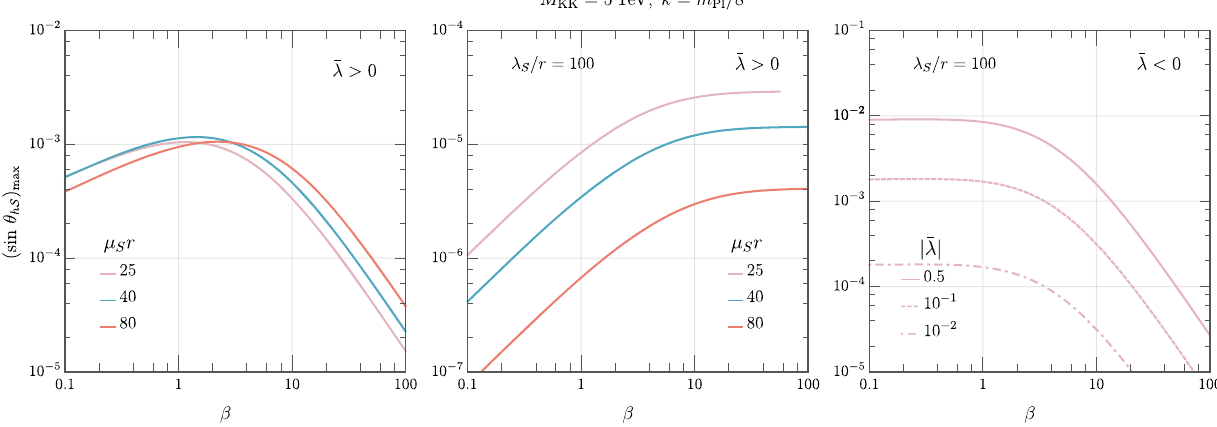
consider the maximum possible values of ¯ λ > 0 and λ S / r , whereas we fix λ S / r to 100 in the middle plot, with ¯ λ still saturating the resulting upper bound. Finally, in the right plot we fix both μ S r and λ S / r and consider three different negative values of ¯